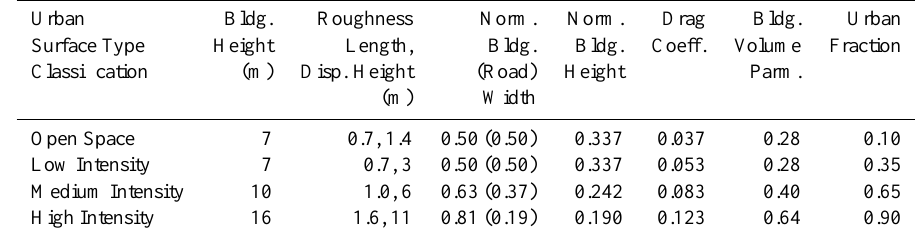
Table 1. Values assigned to gridded urban parameters in the WRF urban canopy model according to surface type. Urban Bldg. Roughness Norm. Norm. Drag Bldg. Surface Type Height Length, Bldg. Bldg. Coeff. Disp. Height